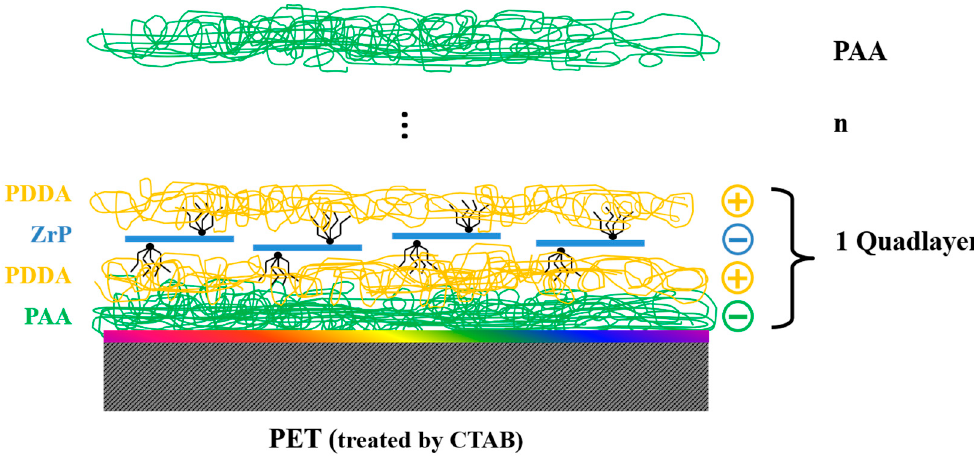
Figure 14. Nanobrick wall structure resulting from qualdlayer assembly of PAA (green), PDDA (orange), ZrP (blue).